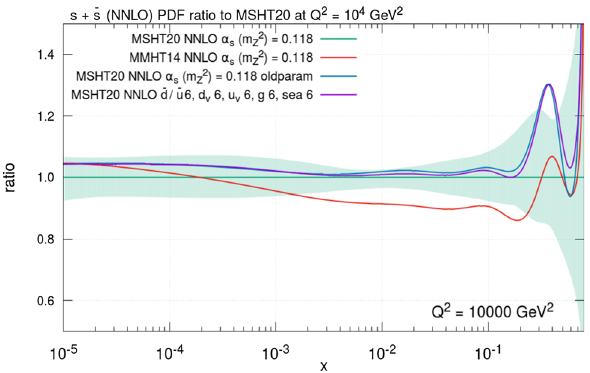
Fig. 46 Ratio of the total strangeness, s + ¯ s , to the MSHT20 default at Q 2 = 10 4 GeV 2 at NNLO showing how incrementing the old parame-